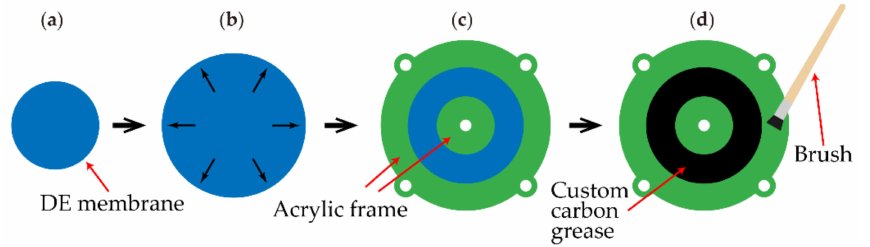
Figure 3. Illustration of the fabrication process of a single unit. ( a ) The initial state of the DE membrane. ( b ) Pre-stretching of the membrane. ( c ) Bonding to acrylic frames. ( d ) Hand-brushing custom carbon